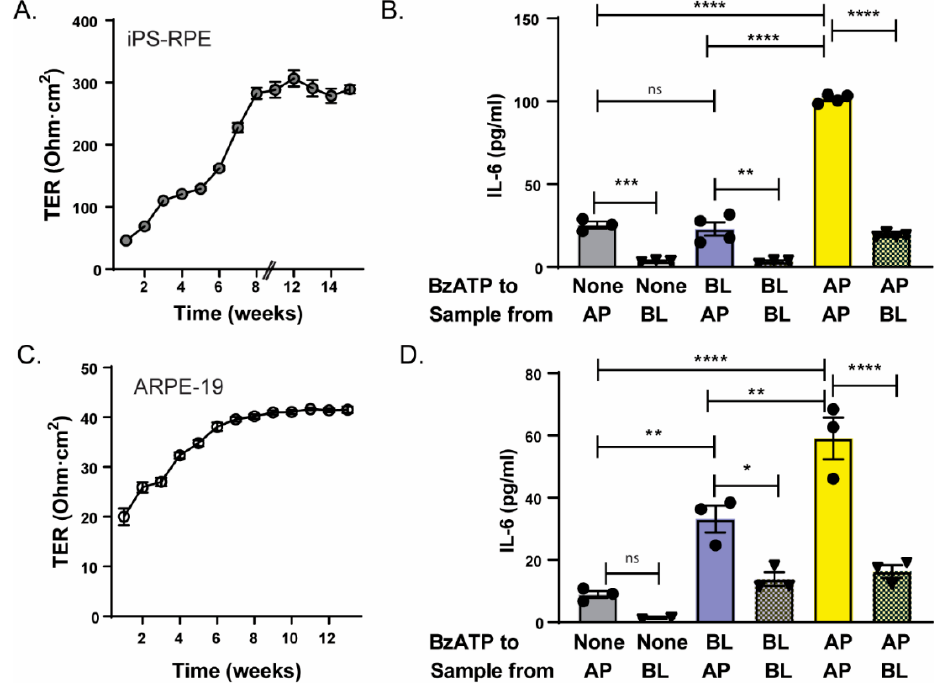
Figure 2. Polarity of IL-6 release. ( A ) Time-dependent changes in TEER of iPS-RPE cells grown on Transwell chambers. Symbols represent the mean ± SEM ( n = 11). ( B ) Polarized release of IL-6 from iPS-RPE cells sampled from the apical (AP) or basolateral (BL) sides of the Transwell insert 2 h after 500 µM BzATP was added to the apical (AP), basolateral (BL) or neither (None) compartment. One way ANOVA F(5,15) = 308.0, p < 0.0001 with Tukey post hoc test (** p < 0.01, *** p < 0.001, **** p < 0.0001, ns = not significant; n = 3–4). ( C ) Time-dependent increases in TEER of ARPE-19 cells grown in Transwell inserts. Symbols represent the mean ± SEM ( n = 20–30). ( D ) Polarized release of IL-6 from ARPE-19 cells sampled from the apical (AP) or basolateral (BL) sides of the Transwell chamber 2 h after 500 µM BzATP was added to the apical (AP), basolateral (BL) or neither (None) compartment. One way ANOVA F(5,11) = 30.56, p < 0.0001 with Tukey’s post-hoc test, * p < 0.05, ** p < 0.01, **** p < 0.0001, ns = not significant.